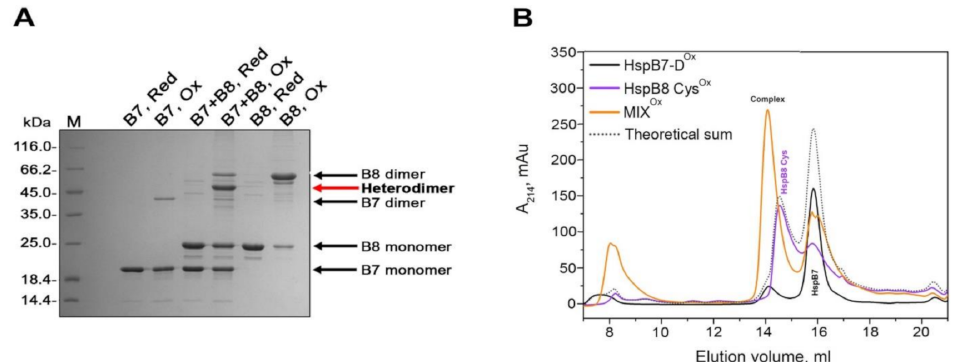
Figure 7. Interaction of HspB7 and HspB8. ( A ) SDS-PAGE of reduced HspB7 (B7, Red), oxidized HspB7 (B7, Ox), reduced mixture of HspB7 and Cys-mutant of HspB8 (B7 + B8, Red), of oxidized mixture of HspB7 and Cys-mutant of HspB8 (B7 + B8, Ox), reduced and oxidized Cys-mutant of HspB8 (B8, Red and B8, Ox). Positions of monomers and dimers of HspB7 and HspB8 are marked by black arrows, position of crosslinked HspB7-HspB8 complex is marked by red arrow. ( B ) SEC of oxidized HspB7 (HspB7-D Ox , black), oxidized Cys-mutants of HspB8 (HspB8 Cys Ox , violet), oxidized equimolar mixture of Cys-mutant of HspB8 and HspB7 (MIX Ox , orange), and arithmetic sum of elution profiles of isolated oxidized HspB7 and HspB8 (Theoretical sum, grey dotted